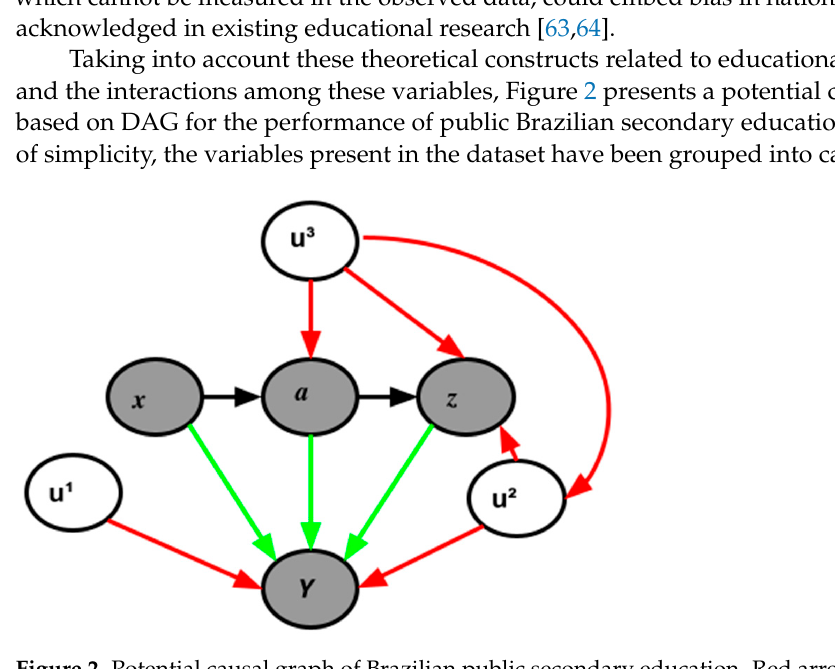
Figure 2. Potential causal graph of Brazilian public secondary education. Red arrows mean effects derived from unobserved variables (white nodes), while green arrows mean effects from observed variables (grey nodes). x , a , and z are observed variables from students and schools, while u variables are unobserved variables from the students (1), schools (2), and states (3). Grey nodes denote the observed variables, where X is the student ´ s non-actionable features, such as sex and race, A is the student ´ s socioeconomics, including parent’s education, and Z is the variables related to schools, including infrastructure, teacher characteristics, and class information. The white nodes denote the unobservable variables U , where the exponents represent the level, with 1 representing student-level variables such as self- confidence, commitment, and cognitive skills, 2 school-level variables related to specific practices, and 3 representing state-level variables related to specific policies. Y represents the final indicator of performance. The red arrows indicate the effects of the unobserved variables on the other variables, and the blue and green arrows indicate the direct effects on